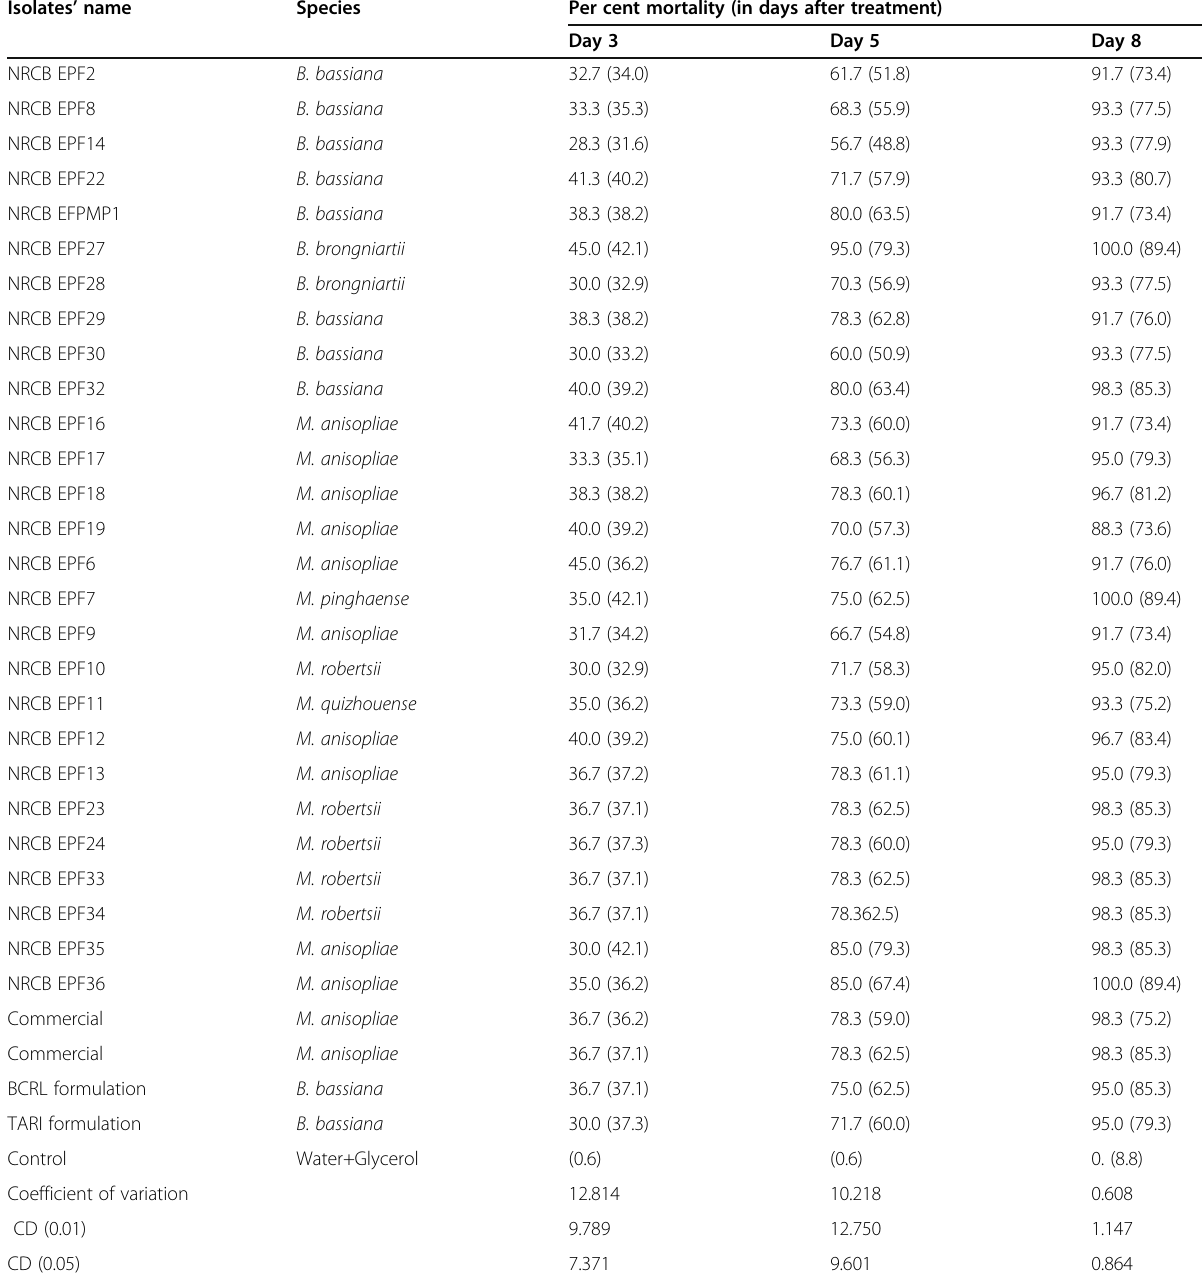
Table 2 In vitro bio-efficacy of Metarhizium and Beauveria isolates against Basilepta subcostata Isolates ’